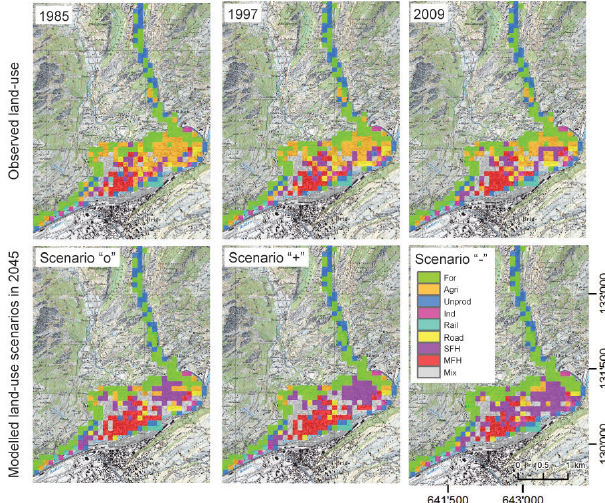
Figure 5. Reclassified land-use data sets of 1985, 1997 and 2009 in Naters (upper row). Modelled land-use scenarios for 2045 (lower row). DEM25 reproduced with permission of Swisstopo (BA110005) and BFS (1986, 1998). For explanation of the abbrevi- ations see Table